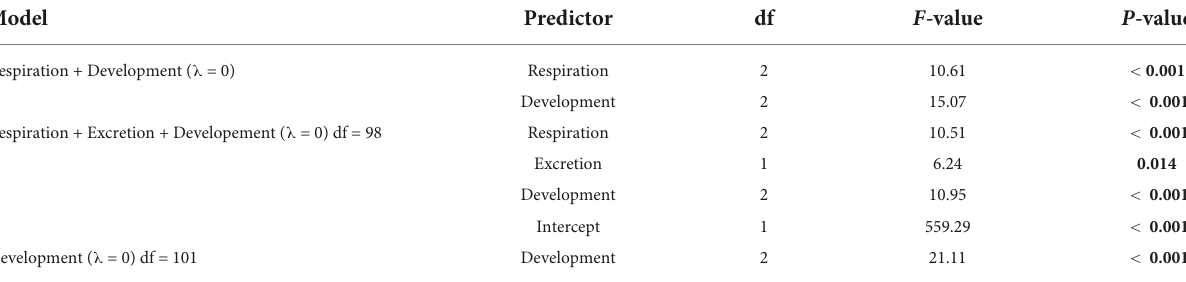
TABLE 5 ANOVA results for the phylogenetic generalized least-square (PGLS) models with (cid:49) AICc < 4 obtained for the subset comprising the species belonging to the infraorders Anomura, Astacidea, and Brachyura.